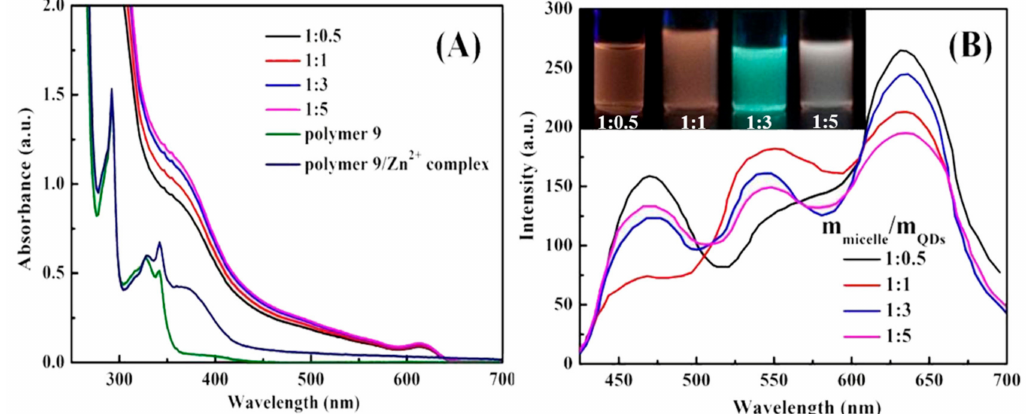
Figure 7. ( A ) UV–Vis absorption spectra of Polymer 9, Polymer 9 / Zn 2 + complex, and CdSe / ZnS@M9 and ( B ) PL spectra of CdSe / ZnS@M9 hybrid micelles with di ff erent micelles / QDs ratio from 1:0.5 to 1:5 (Inset: Digital images of CdSe / ZnS@M9 with micelles / QDs ratio from 1:0.5 to